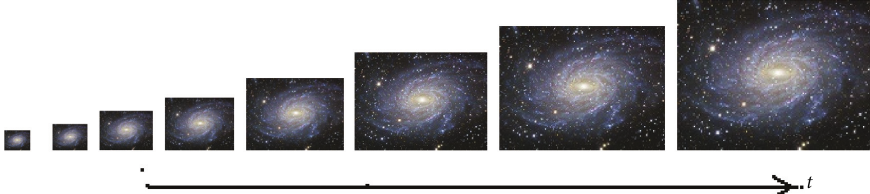
Figure 3: Schematic diagram of Gradual growth of the Milky